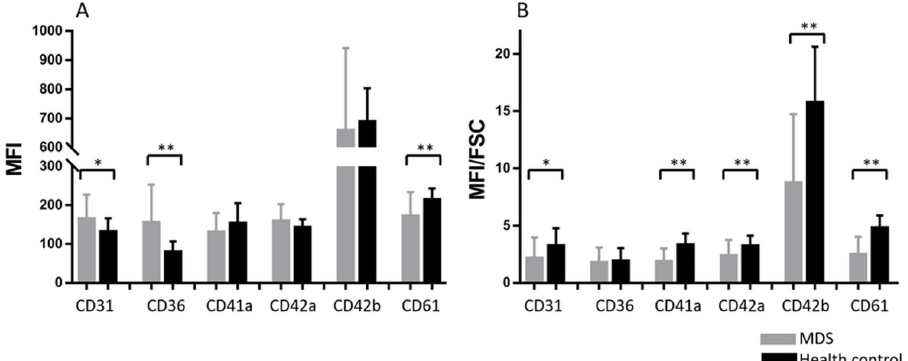
Fig 1. (A) The level (MFI) of CD31, CD36, CD41a, CD42a, CD42b and CD61 on the platelets of MDS patients (MDS, n = 20) and healthy controls (HC, n = 20). (B) The MFI adjusted by diameter (MFI/FSC) of CD31, CD36, CD41a, CD42a, CD42b and CD61 on the platelets of MDS patients (MDS, n = 20) and healthy controls (HC, n = 20). Data were shown in mean ± SD. An unpaired t-test was employed to examine the difference between MDS patients and healthy controls. � P-value < 0.05; �� P-value < 0.001.